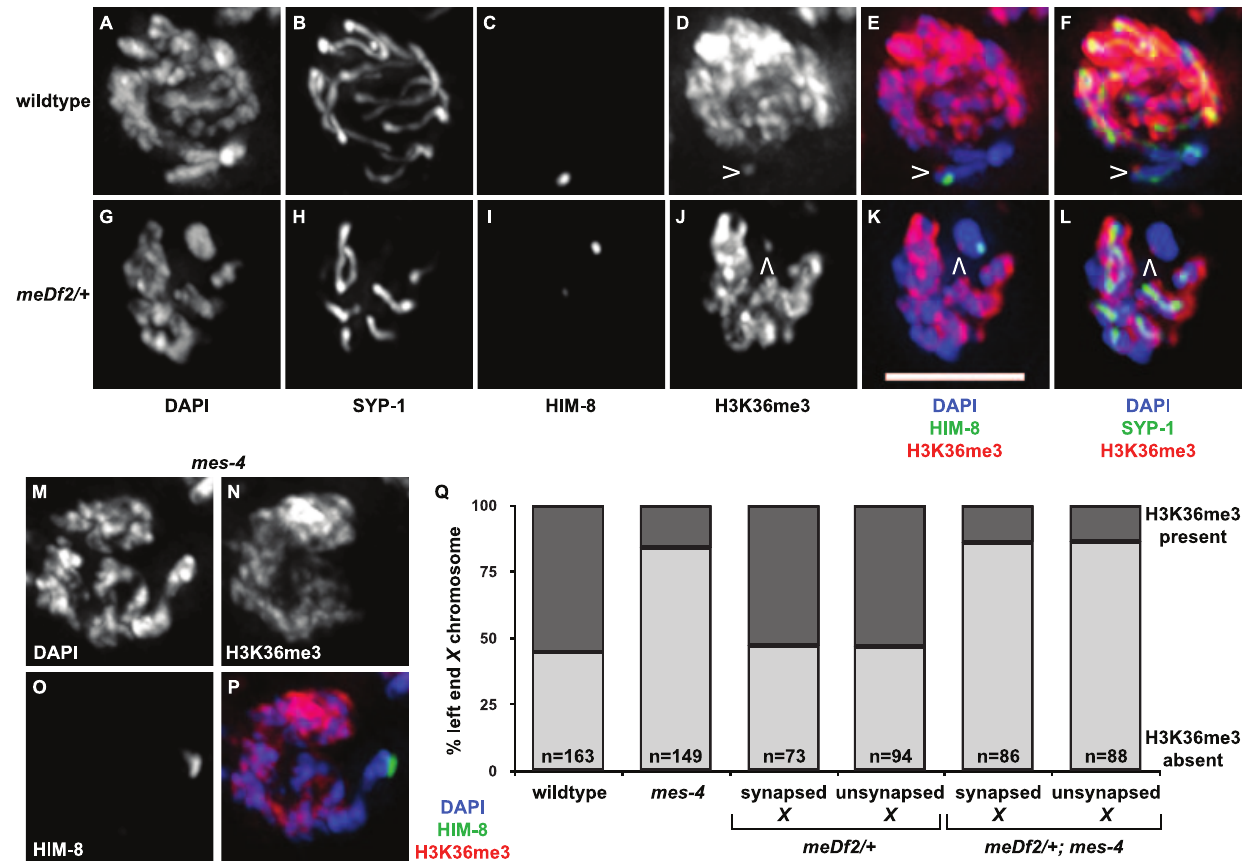
Figure 7. Is H3K36me3 the relevant chromatin modification for synapsis checkpoint activation? A–L. Indirect immunofluorescence was performed on meiotic nuclei in wildtype and meDf2 heterozygotes against SYP-1, HIM-8 and H3K36me3. H3K36me3 is depleted from X